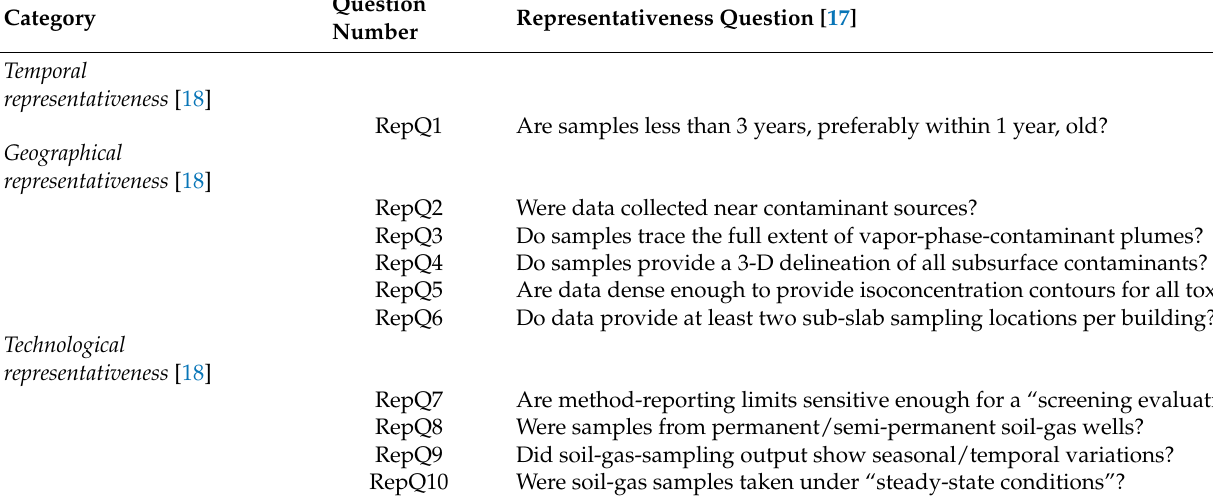
Table 2. Representativeness questions based on US Environmental Protection Agency (EPA) [18] and California (CA) Department of Toxic Substances Control (DTSC) [17] testing